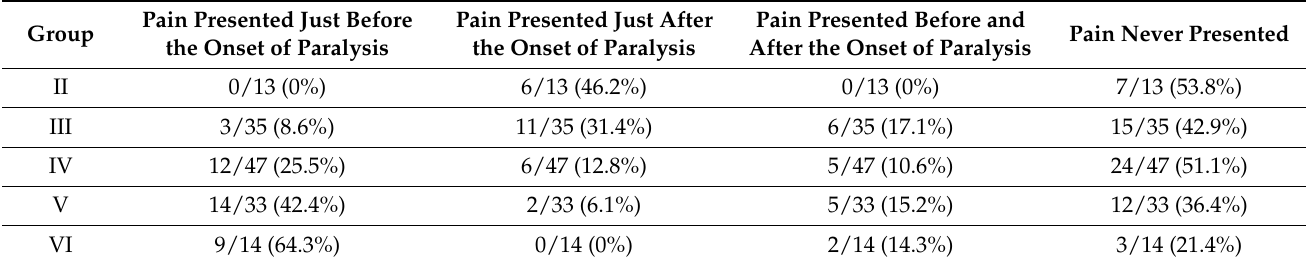
Table 2. The presence of RAP (retroauricular pain) in different groups of patients at different stages of IBP. Pain Presented Just Group